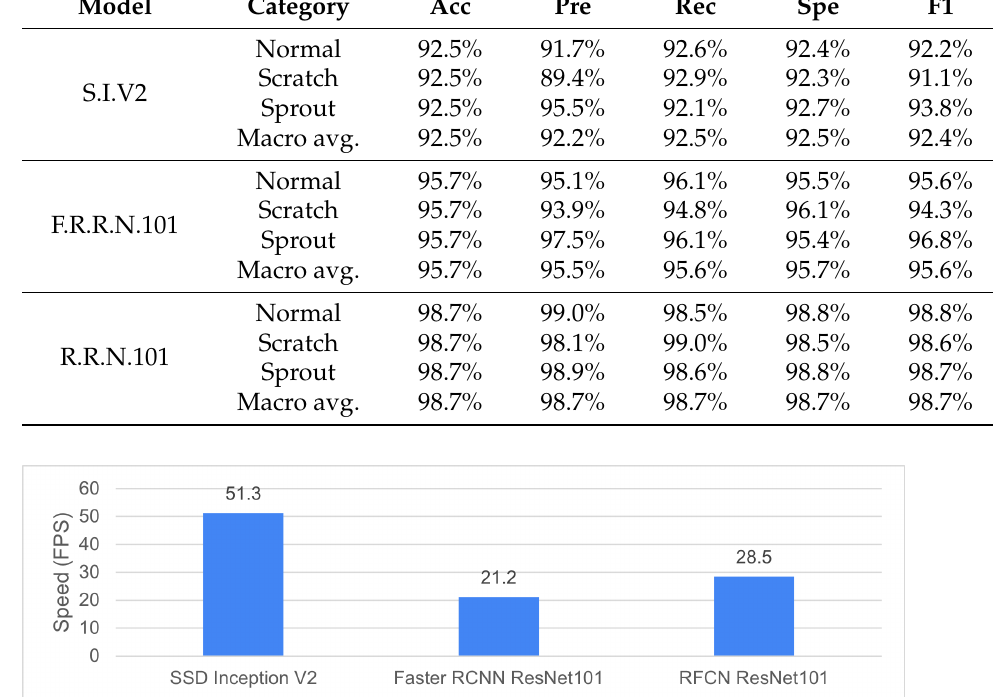
Figure 12. Inference speed.